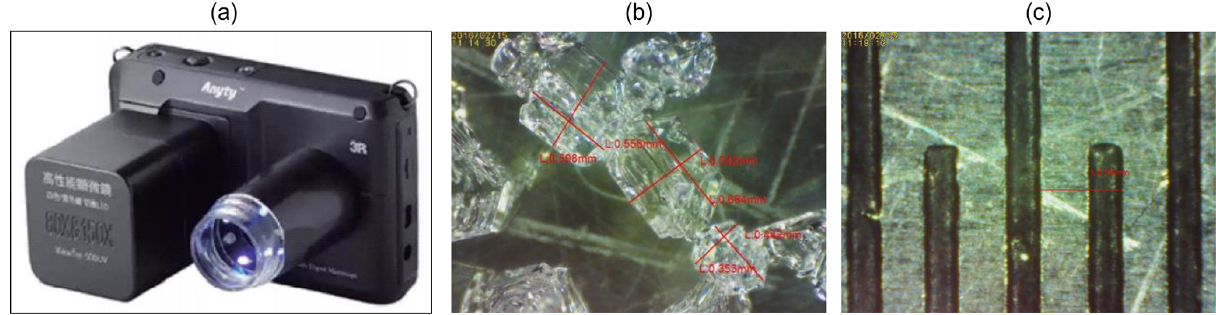
Figure 3. (a) Picture of microscope “Anyty V500IR/UV”, (b) the measured lengths of the longest and shortest axes of particles, and (c) the reference ruler scale.